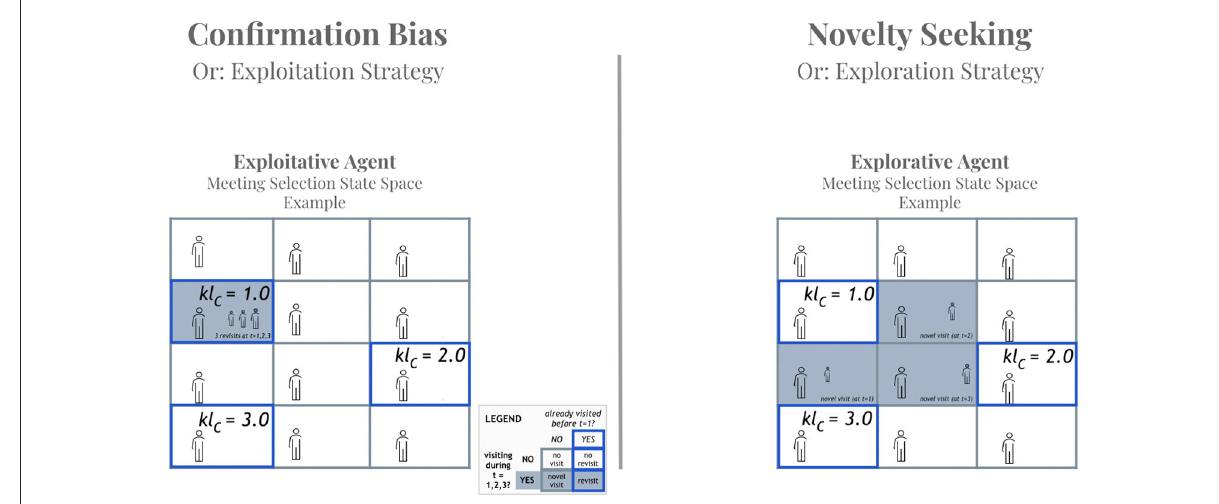
FIGURE4 A simplified example of exploitation- and exploration-driven strategies for meeting selection. This Figure illustrates the behavioral differences between the extreme cases of being fully driven by exploitation (Left) or exploration (Right) . Each cell on the grid corresponds to a potential interlocutor for these agents, who make decisions in three consecutive time steps ( t = 1,2,3) and have previously engaged with three other interlocutors (marked with blue rectangles), where we use the shorthand kl C to indicate the pragmatic component of the expected free energy G pragmatic , visit = o expr , visit · (lno expr , visit − C idea ), which corresponds to the KL divergence between expectations about the interlocutor at that location (as informed by previous visits) and the preferred ideas of our agents, such that lower values correspond to a better match. Cells that are visited during t = 1,2,3 are filled with granite. The exploitation-driven agent (Left) simply revisits three times a known interlocutor with the lowest KL C . In contrast, the exploration-driven agent (Right) prefers novel visits and switches to an unknown agent every time step. In the simulations presented later, agents will dynamically balance these two strategies as their preferences themselves evolve over